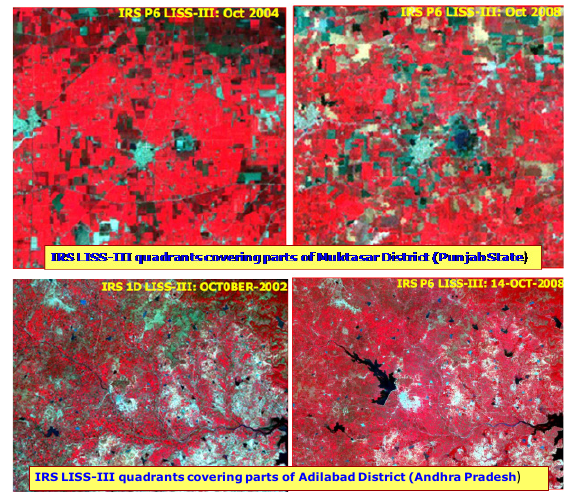
Figure-2: IRS LISS-III quadrants covering parts of Muktasar